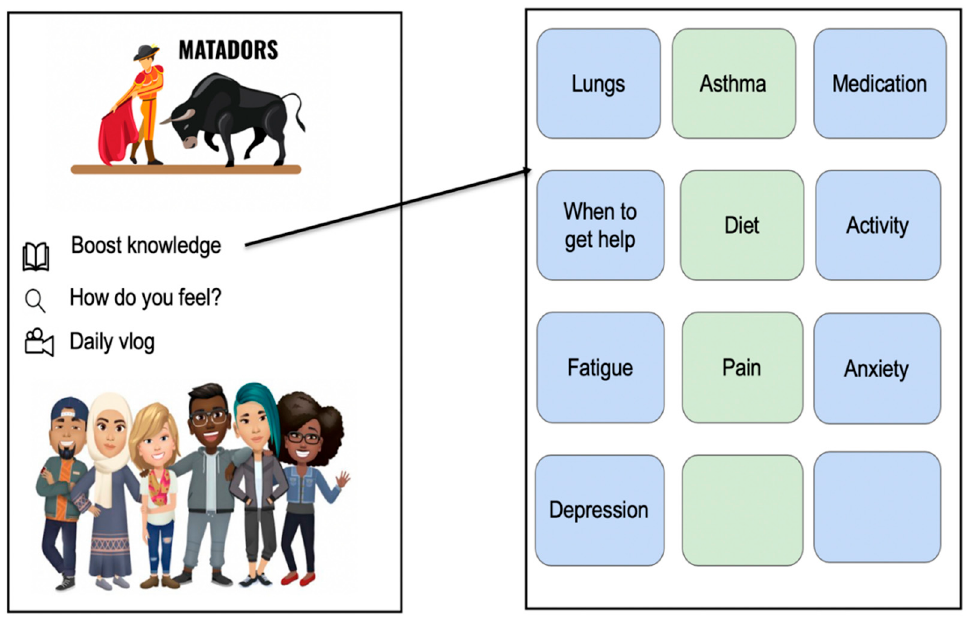
Figure 2. An exemplar of Wireframe Layout.